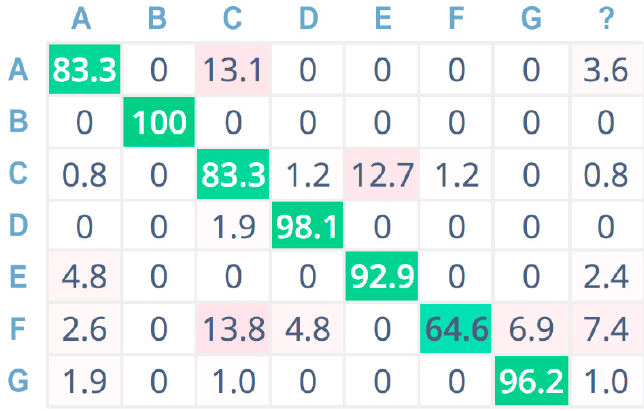
Figure 12. Confusion matrix adopting MFCC pre-processing, 8 bit.